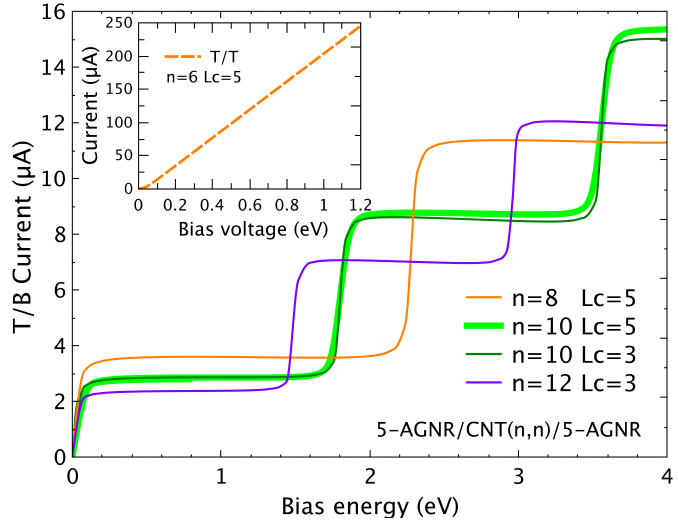
Figure 6. (Color online) Current versus bias potential applied on the left top and right bottom leads for a 5-AGNR/CNT(n,n)/5-AGNR for n = 8, 10, and 12, and conductor spacer L c = 3 and 5. Inset: T/T Current for n = 6 and L c =